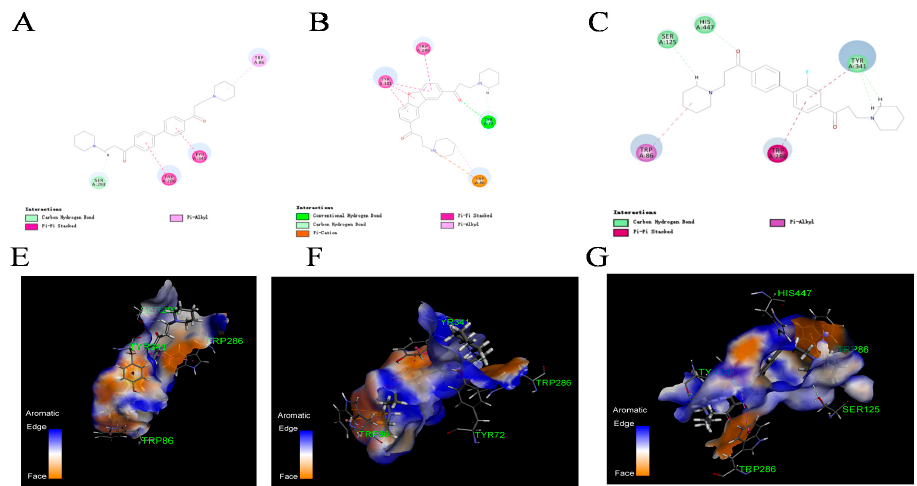
Figure 4. Visualization of the non-bond interactions between the protein and ligand. ( A , B ) showed the interaction AChE with DL0410. Biphenyl and piperidine rings of DL0410 interacted with TRP286, TYR341, and TRP86 via π - π stacking or π -alkyl interaction. Compound 6-1 showed a strong interaction with AChE. Except for TRP286, TYR341, and TRP86, compound 6-1 could form hydrogen bonds with TRP72. Compound 7-6 also had a powerful interactions with AChE, mainly through π - π stacking, π -alkyl, and hydrogen bond interaction.